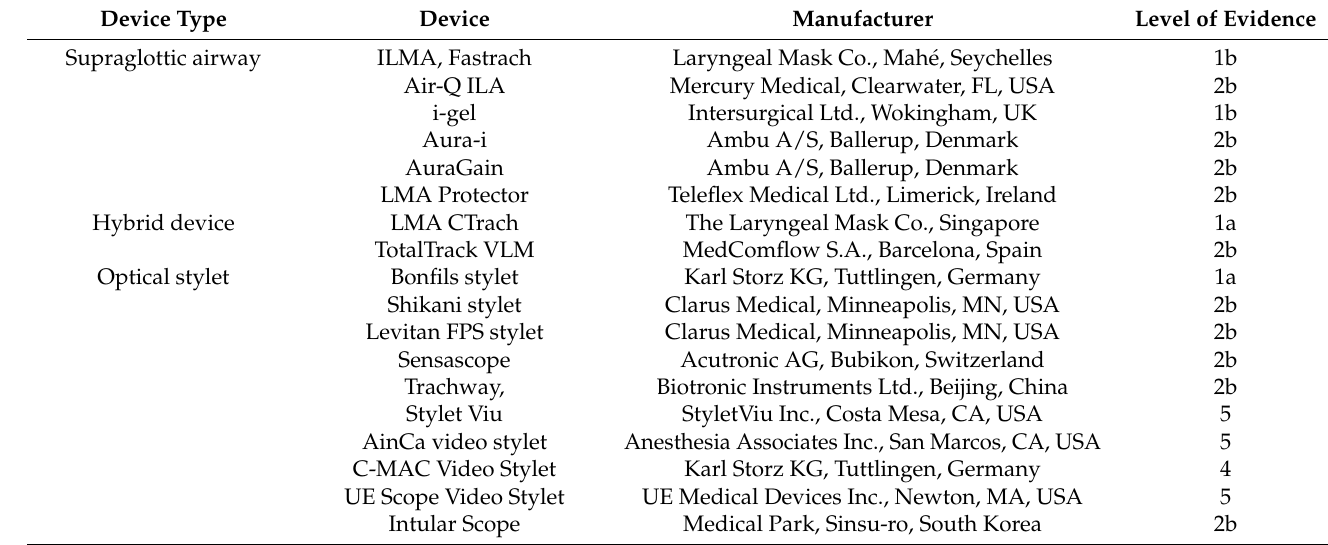
Table 1. Optical devices used for tracheal intubation and their highest available level of